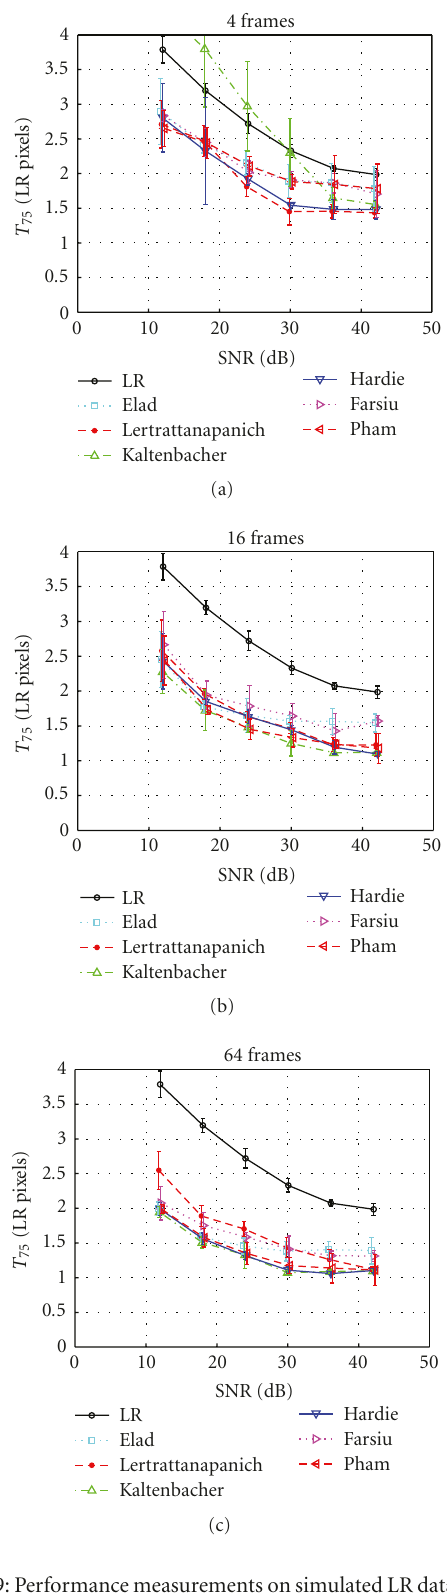
Figure 9: Performance measurements on simulated LR data ( σ PSF = 0 . 2, ff = 100%) processed with di ff erent SR reconstruction methods (zoom factor 2) with optimized settings, (a) 4 frames, (b) 16 frames, (c) 64